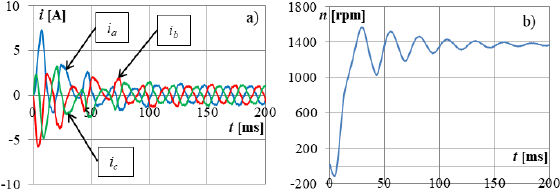
Fig. 1. The waveforms of the phase currents (a) and the rotational speed n (b) during the start-up of the IM.